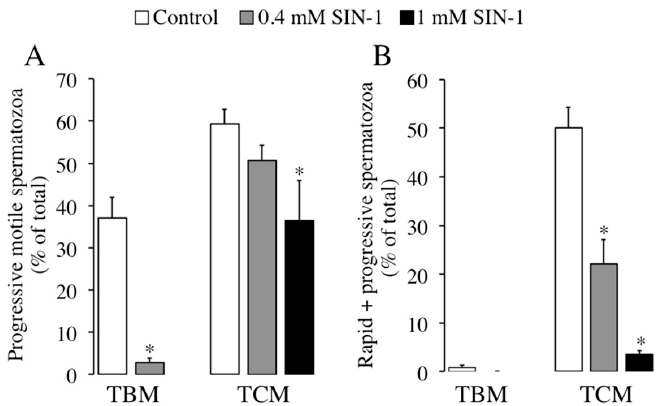
Figure 2. E ff ects of SIN-1 induced-peroxynitrite in the percentages of progressive motile and rapid + progressive motile boar spermatozoa. Spermatozoa were incubated in TBM or TCM at 38.5 ◦ C in the absence (white histograms) or the presence of indicated concentrations of SIN-1 (filled histograms) for 1 h. Sperm motility parameters were evaluated by ISAS ® system: the percentages of motile spermatozoa with progressive motility ( A ) and rapid and progressive motility ( B ) are shown. This experiment was performed 8 times ( n = 8) and results are expressed as the mean of the percentage of total sperm ± SEM. Statistical di ff erences are shown with * ( p < 0.05).